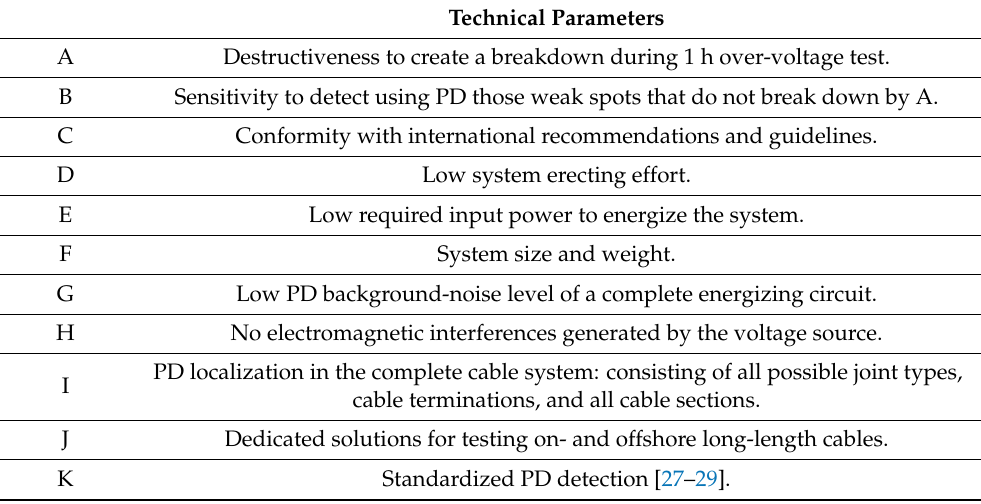
Table 7. Example of technical parameters to compare AC resonance test and damped ac test methods regarding long-length power